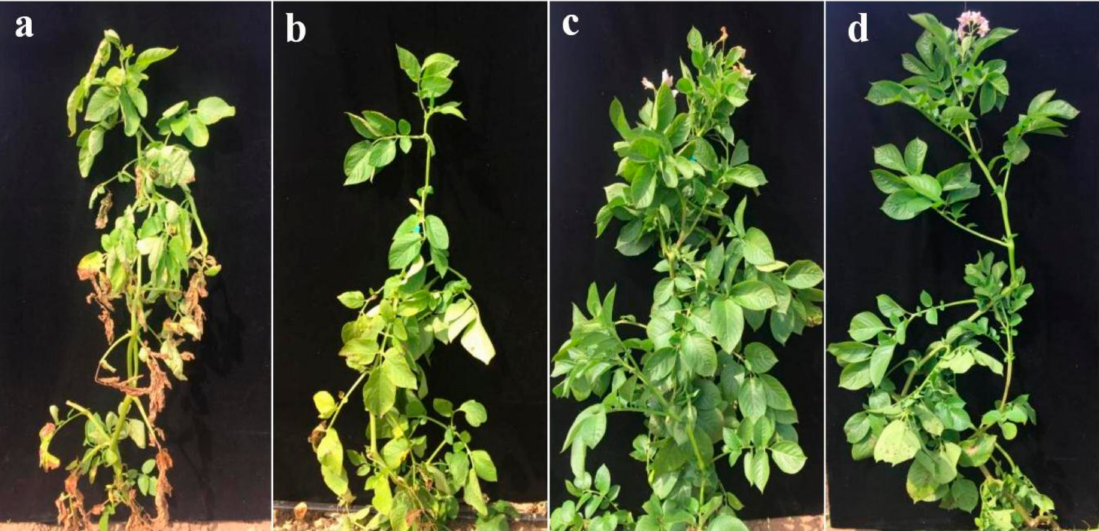
Figure 1. The grafted plant maturity at 80 days after emergence: ( a ) Z5/Z18 grafted plant, early- maturing cultivar Z5 was grafted onto late-maturing cultivar Z18; ( b ) Z5/Z5 grafted plant, early- maturing cultivar Z5 was self-grafted; ( c ) Z18/Z5 grafted plant, late-maturing cultivar Z18 was grafted onto early-maturing cultivar Z5; ( d ) Z18/Z18 grafted plant, late-maturing cultivar Z18 was self-grafted.